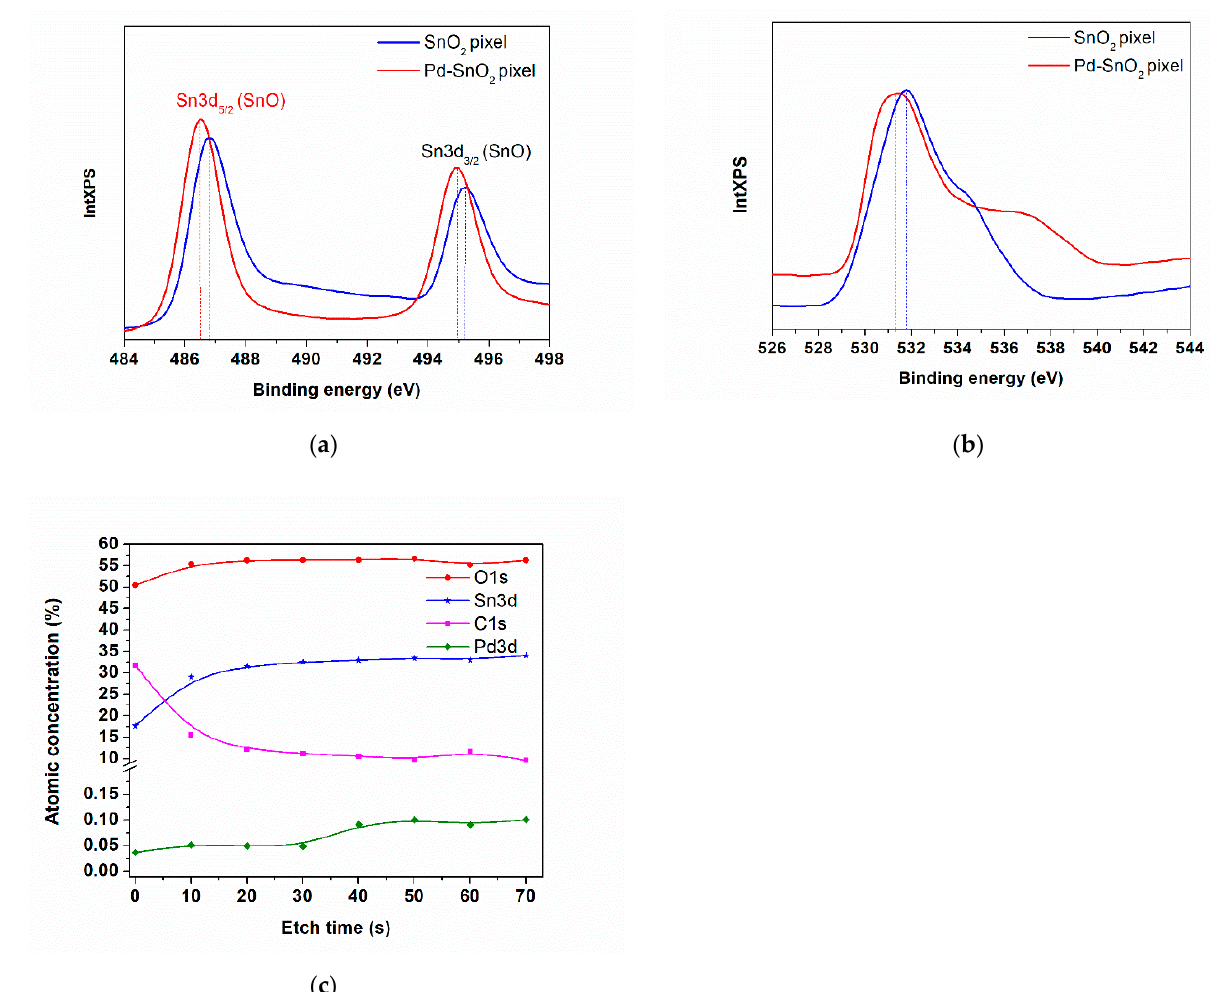
Figure 6. ( a )Sn 3d, ( b ) O1s core-level XPS spectra of SnO 2 and Pd-SnO 2 pixels transferred at 100 mJ/cm 2 ; ( c ) Evolution of O, C, Sn and Pd as a function of etching time.